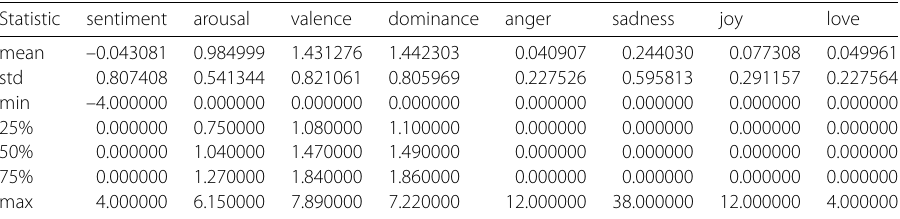
Table 2 Summary statistics of affect metrics for Bitcoin. Mean, standard deviation, min-max values considering all Github comments for sentiment, arousal, valence, dominance, anger, joy, love